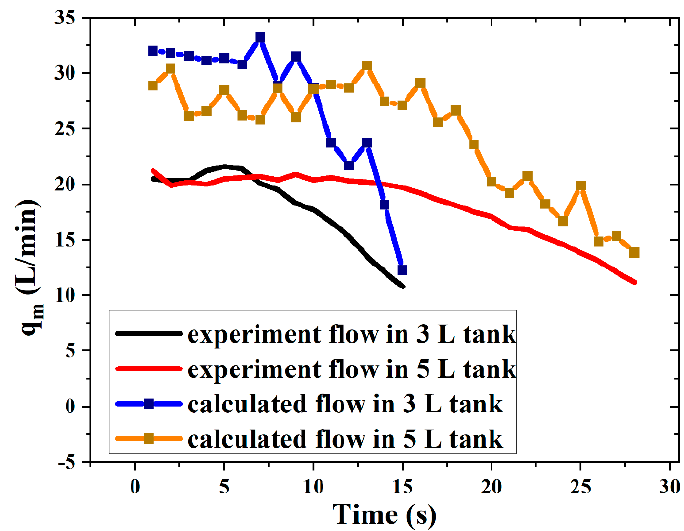
Table 2. Goodness of fit of overall heat transfer coefficient index model.